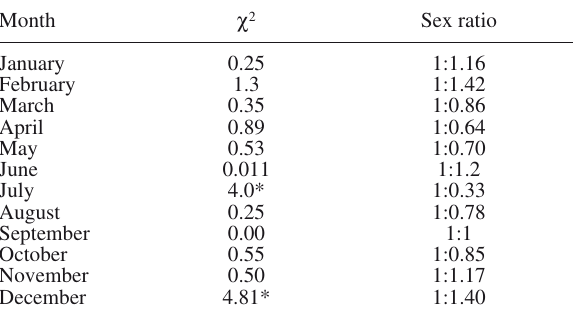
Asterisks refer to significant p values. * p